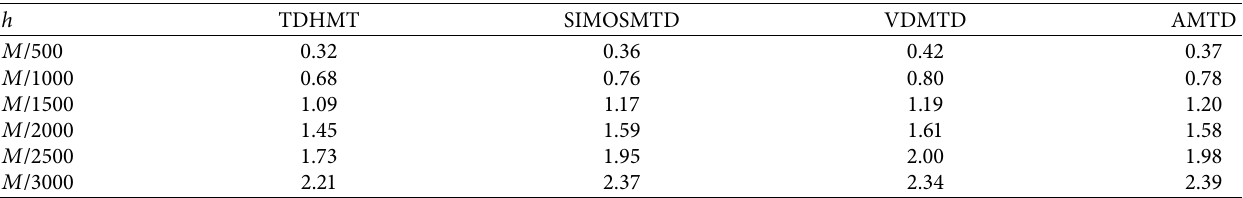
Table 8: Comparison of the CPU time of TDHMT with the CPU time of other existing methods, namely, SIMOSMTD, VDMTD, and AMTD for Example 4.